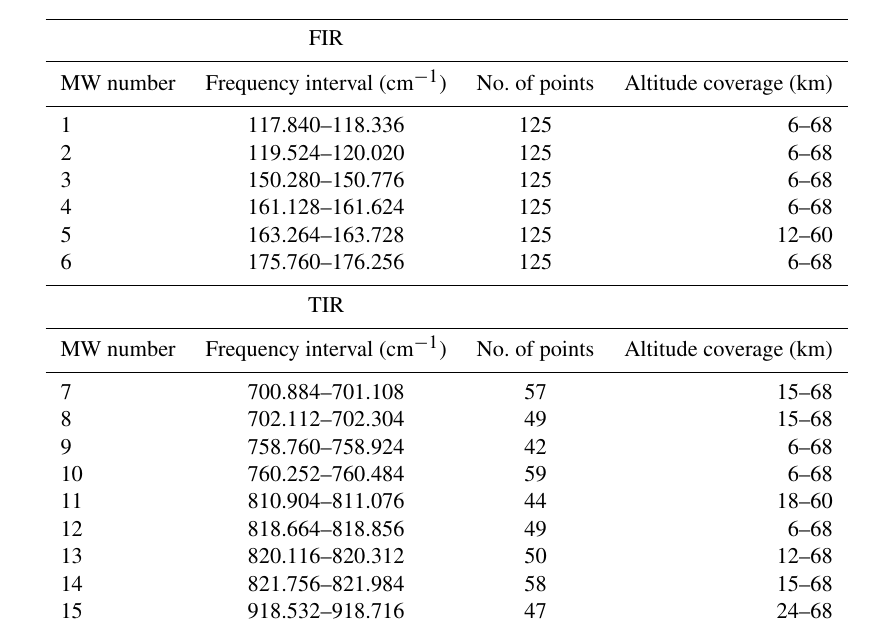
Figure 2. (a) IL with respect to T of the FIR MWs. (b) : IL with respect to T of the TIR MWs. (c) IL with respect to CO 2 VMR of the TIR MWs, (d) T field of the reference atmosphere. Table 2. Definition of the MWs selected for the retrieval